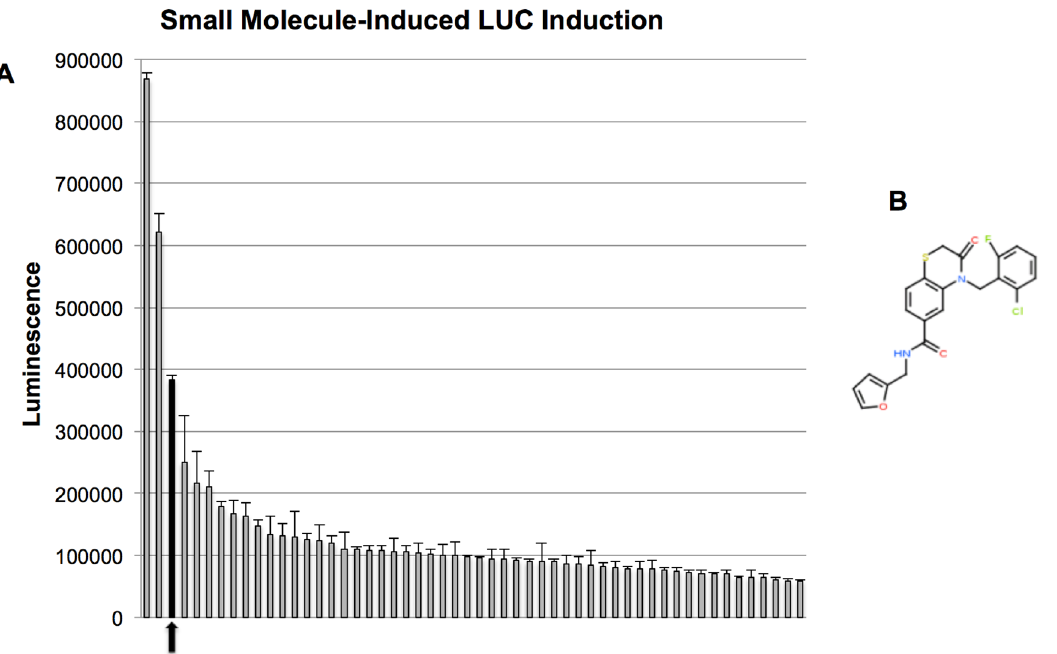
Fig 1. High Throughput Identification of G10. A. Luciferase (LUC) expression of top tier candidate molecules as described in text from a high throughput screen of 51,632 compounds. (A) Presented values represent the average ± SD of duplicate assays. Black bar and arrow indicate LUC signal generated by G10. (B) Chemical structure of 4-(2-chloro-6-fluorobenzyl)-N-(furan-2-ylmethyl)-3-oxo-3,4-dihydro-2H-benzo[b][1,4]thiazine-6-carboxamide (G10).